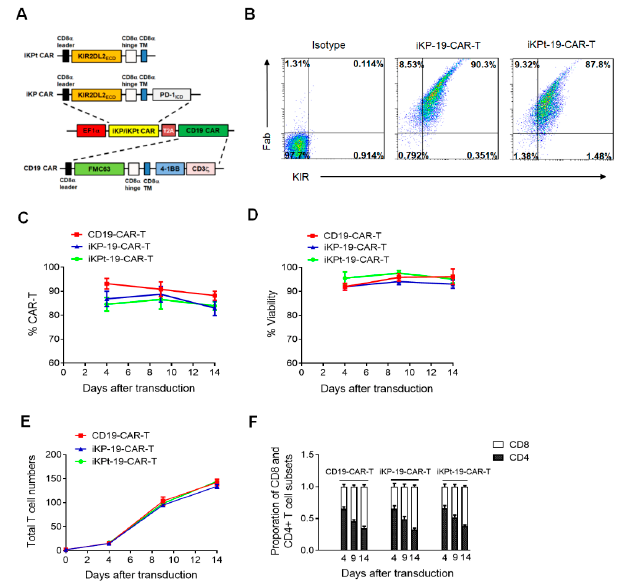
Figure 1. iKP CAR construction and expression. ( A ) Schematic diagram of the bicistronic vector expressing iKP / iKPt CAR and CD19 CAR. ( B – F ) iKP-19-CAR-T / iKPt-19-CAR-T cells or CD19-CAR-T cells were cultured for 14 days in X-VIVO media supplemented with 100U / mL IL-2. Representative iKP / iKPt CAR and CD19 CAR expression in iKP-19-CAR-T / iKPt-19-CAR-T cells were detected on day 4 by flow cytometry using PE-anti-human KIR antibody and Alexa Flour 647-anti-mouse F(ab’)2 antibody (scFv of CD19 CAR is from mouse) ( n = 4 di ff erent donors) ( B ). Detection of CD19 CAR-positive rate in iKP-19-CAR-T / iKPt-19-CAR-T and CD19-CAR-T on day 4, day 9 and day 14 by flow cytometry ( n = 4 di ff erent donors) ( C ). Viability ( D ) or total cell numbers ( E ) of iKP-19-CAR-T / iKPt-19-CAR-T cells and CD19-CAR-T cells were also measured on day 4, day 9 and day 14 using Beckman Coulter counter ( n = 4 di ff erent donors). Proportion of CD8 + and CD4 + T cell subsets in iKP-19-CAR-T / iKPt-19-CAR-T cells or CD19-CAR-T cells on day 4, day 9 and day 14 was measured using APC-anti-human CD8 antibody and PerCP-anti-human CD4 antibody ( n = 4 di ff erent donors) ( F ). Three experiments were performed using PBMCs from each donor. Error bars represent ±